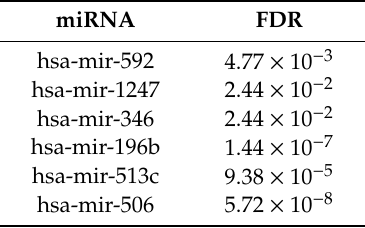
Table 2. FDR of di ff erentially expressed miRNA selected for validation in tumor samples.